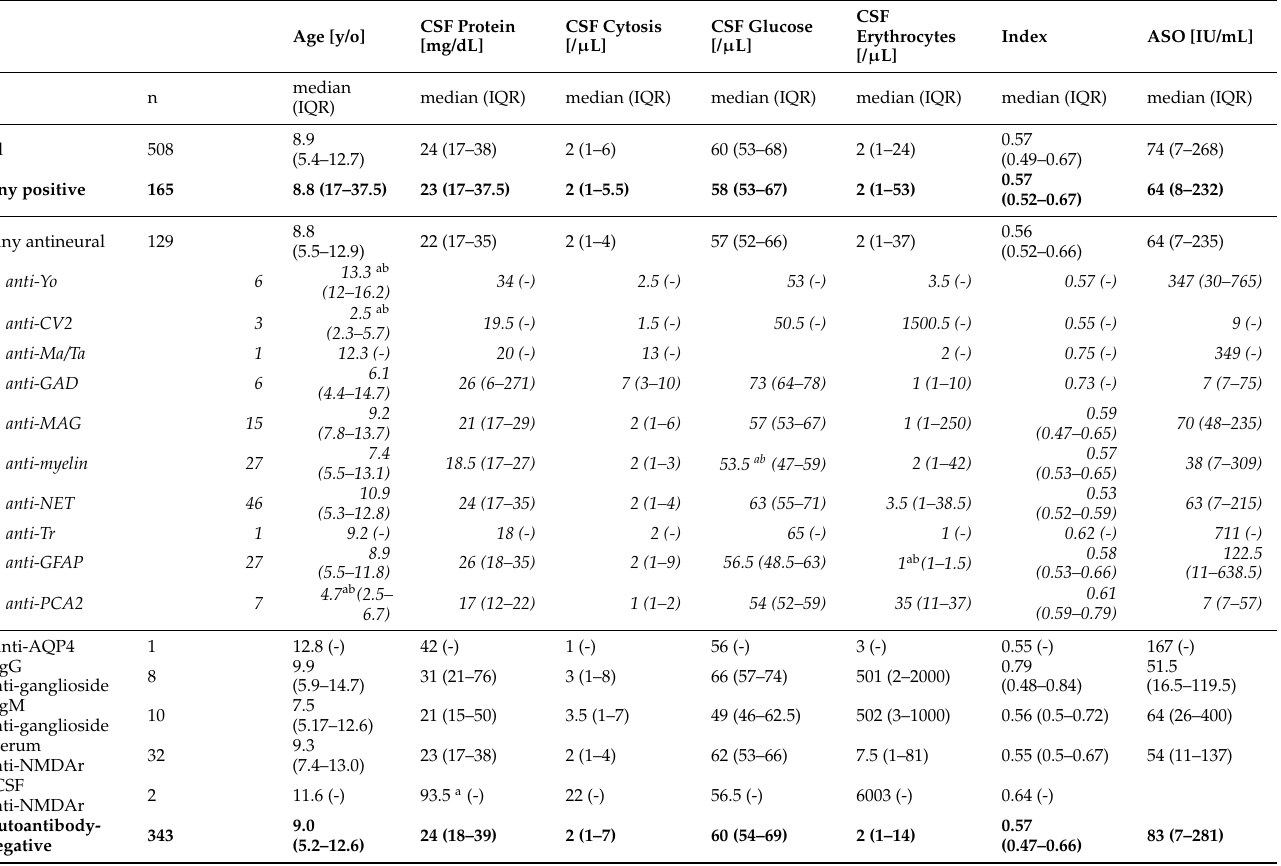
Table 2. Median and IQR values of analysed parameters with the division based on detected